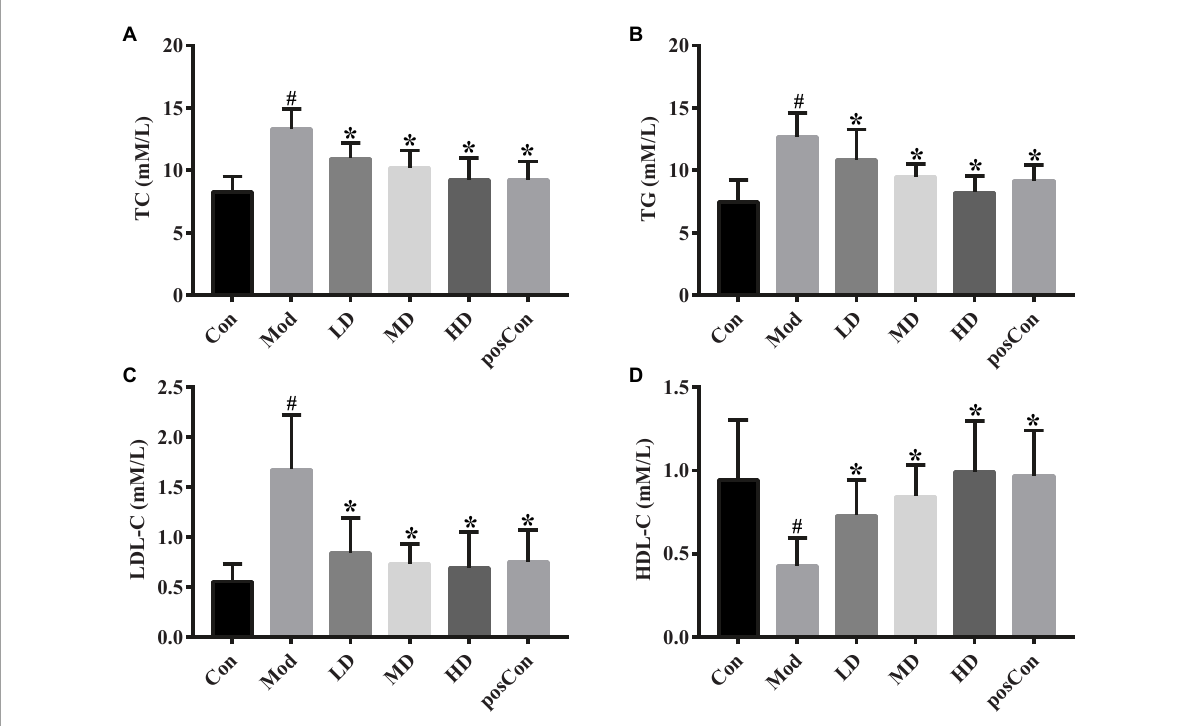
FIGURE1 Altered plasma lipids by ACNE. The above bar graphs showed the plasma level of TC (A) , TG (B) , LDL-C (C) , and HDL-C (D) , respectively. The p -value less than 0.05 was considered statistical significance. # p < 0.05, compared to the Con group; * p < 0.05, compared to the Mod group.